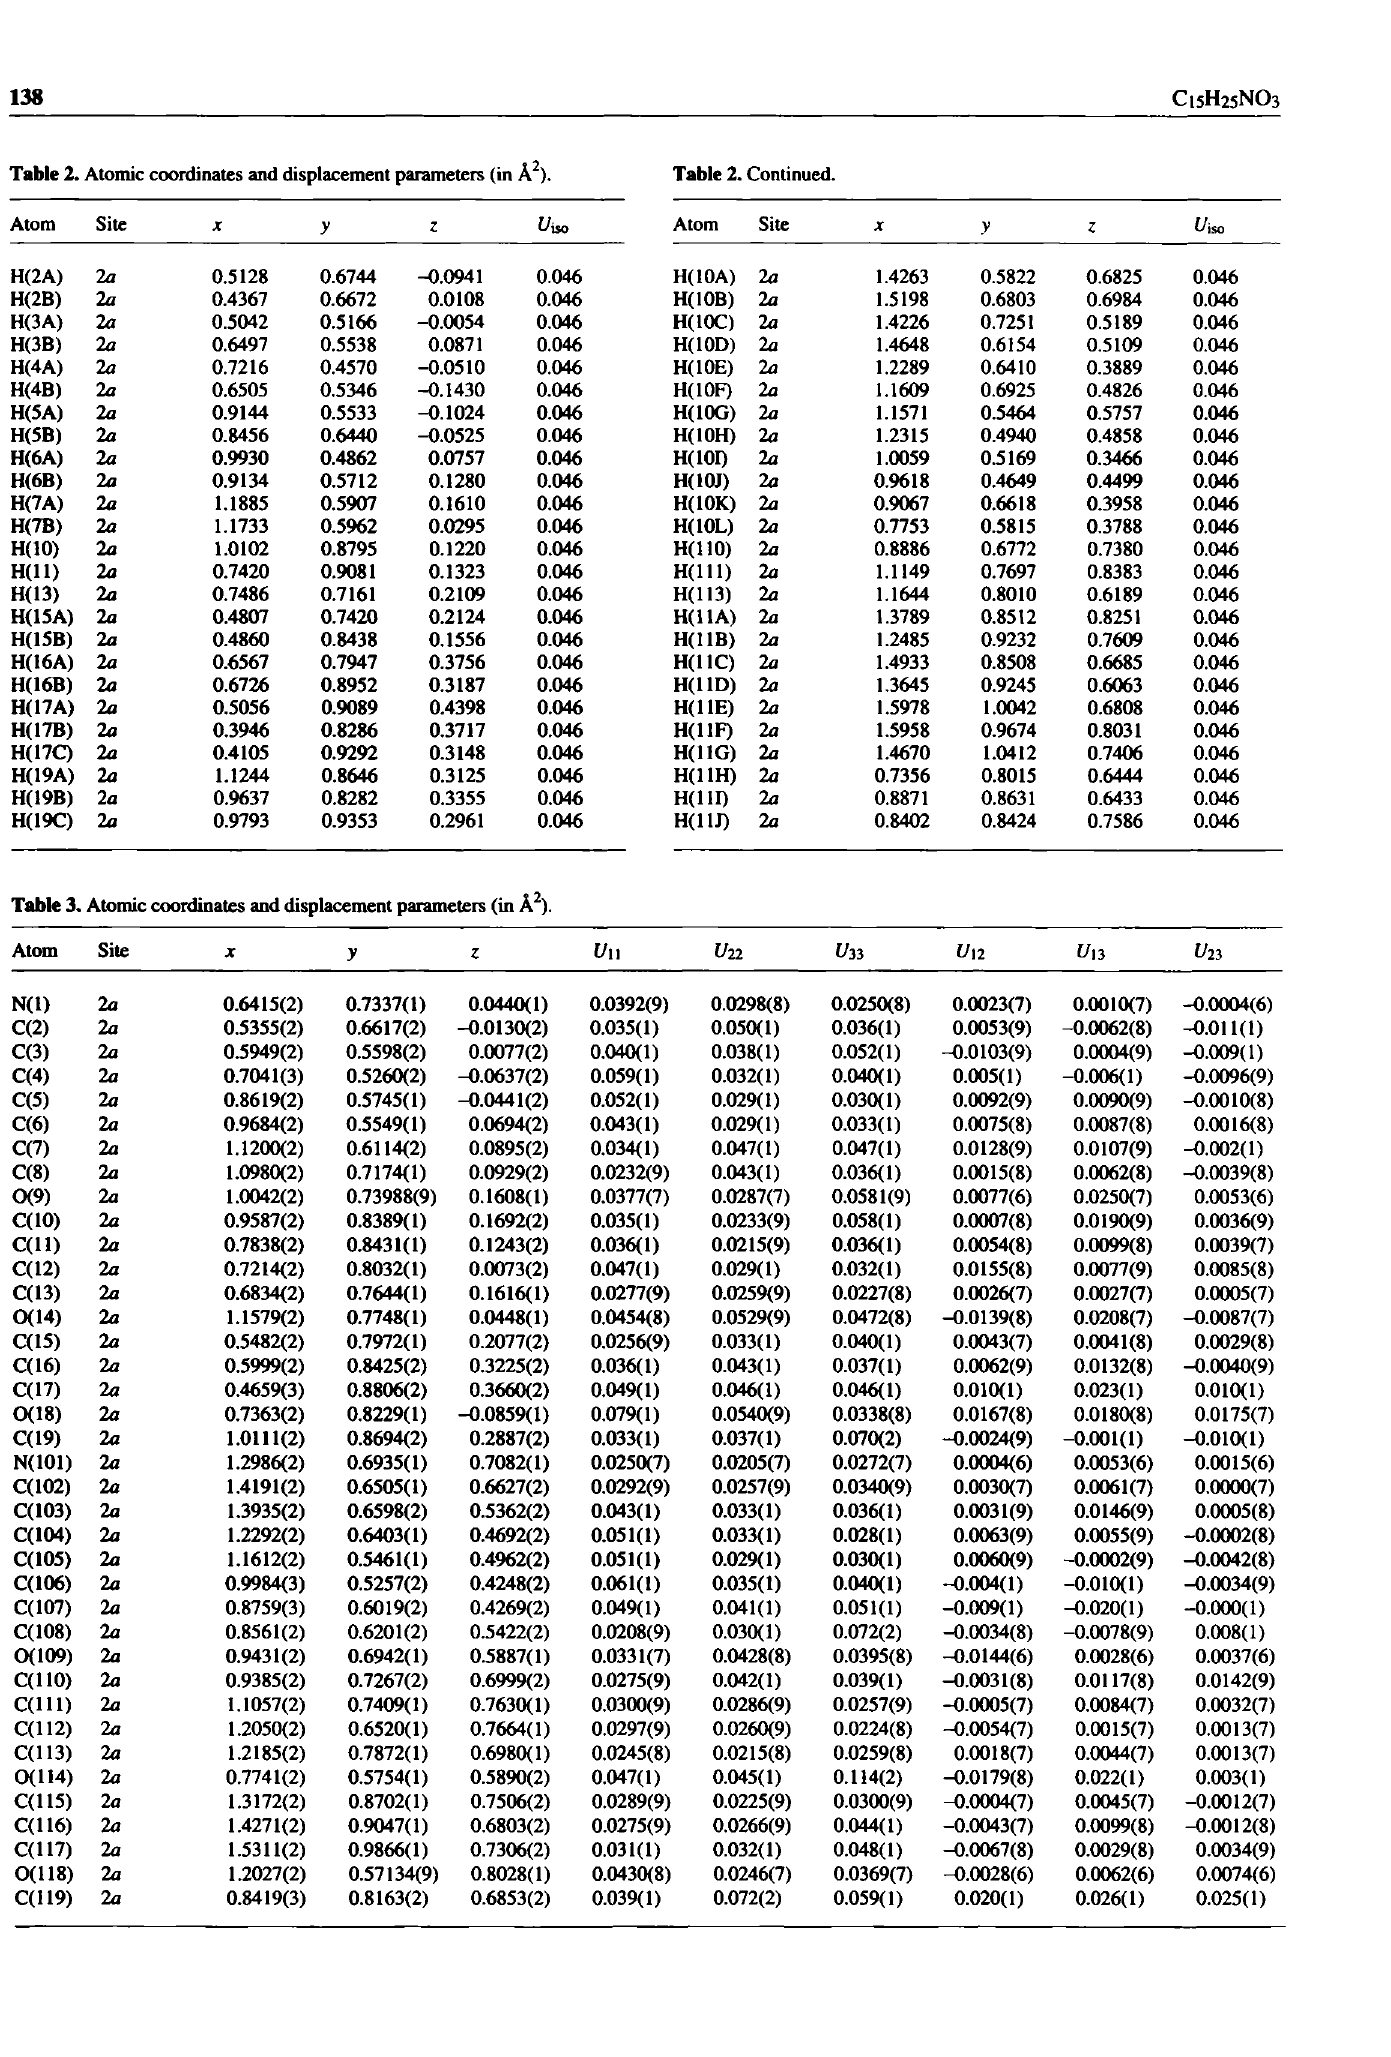
Table 3. Atomic coordinates and displacement parameters (in Â 2